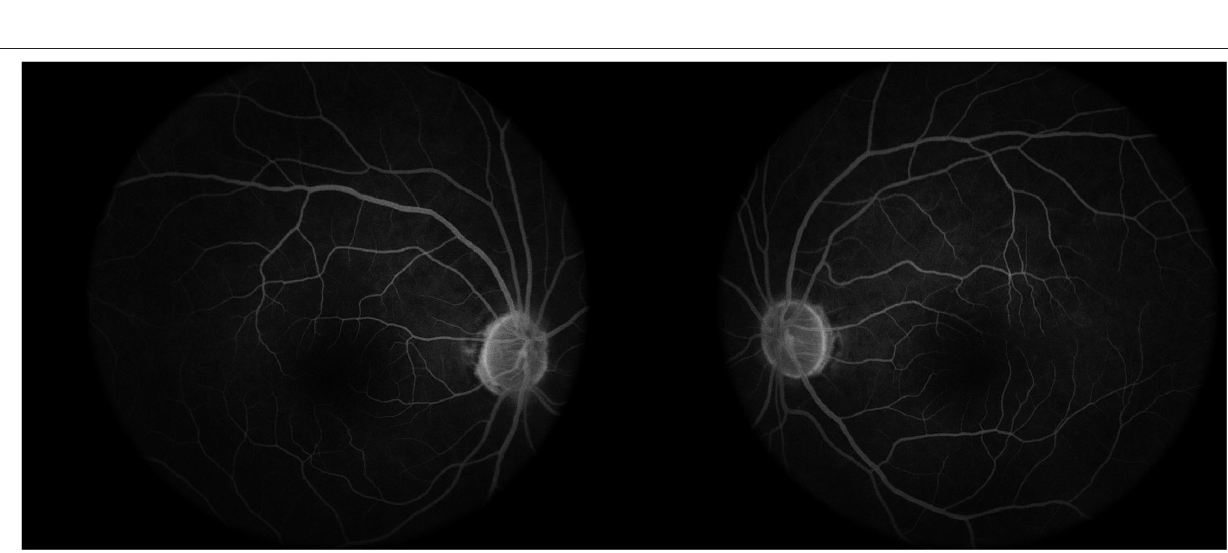
14.62 ± 3.04 mmHg and 13.07 ± 2.99 mm in the healthy controls and prediabetes patients. The mean diopter values were 1.2 ± 3.18 D and 0.38 ± 1.64 D in the healthy controls and prediabetes patients. The mean axis lengths were 23.22 ± 1.10 mm and 23.07 ± 1.32 mm in the healthy control group and prediabetes group. Prediabetes patients matched in age ( p = 0.15), gender ( p = 0.99), BCVA ( p = 0.09), IOP ( p = 0.36), spherical equivalent ( p = 0.24), and axis length ( p = 0.44) ( Table 1 ) served as healthy